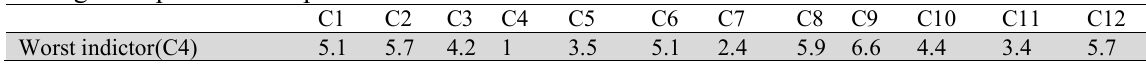
Average comparison of experts in the worth